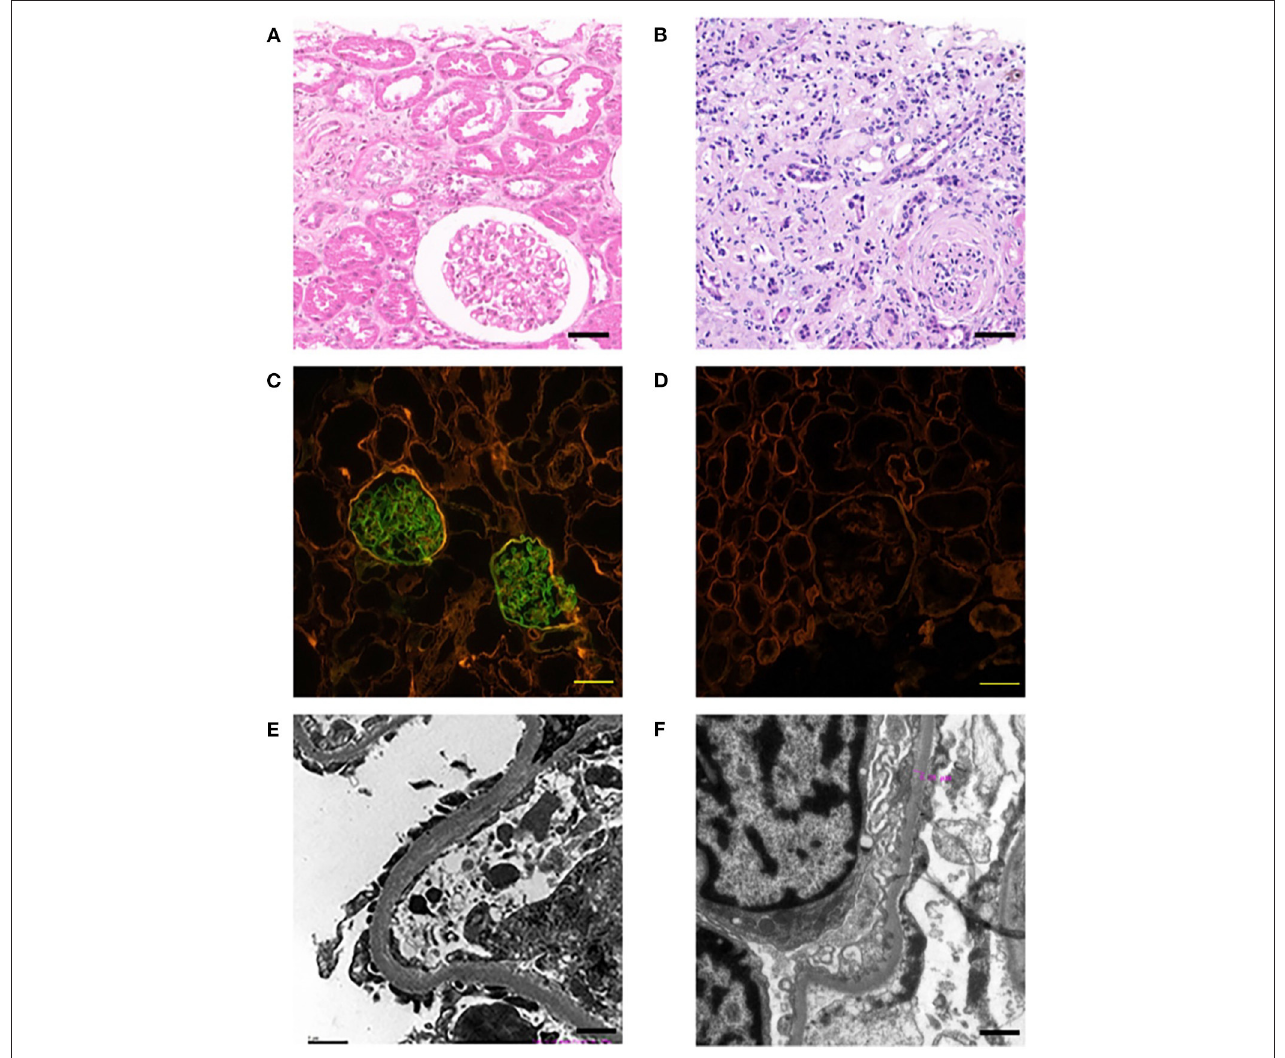
FIGURE 4 | Pathological examination results of probands. The left panel (A,C,E) show the results of the first renal biopsy (March 10, 2009), and the right panel (B,D,F) show the results of the second renal biopsy (August 28, 2015). (A) HE staining is characterised by FSGS. Scale bars, 100 µ m. (B) HE staining is characterised by AS. Scale bars, 100 µ m. (C) Immunofluorescence staining of α 5 chain (IV) showed that the expression of α 5 chain was normal; the immunofluorescence staining was positive, which emitted bright green fluorescence by a confocal laser scanning microscope. Scale bars, 20 µ m. (D) Immunofluorescence staining of α 5 chain (IV) showed the absence expression of α 5 chain; the immunofluorescence staining was negative, which showed no emitted bright green fluorescence by a confocal laser scanning microscope. Scale bars, 20 µ m. (E) The electron microscope examination showed that the basement membrane was normal. Scale bars, 1 µ m. (F) The electron microscope examination showed that the glomerular basement membrane was uneven in thickness, about 200–500nm. Scale bars, 1 µ m.